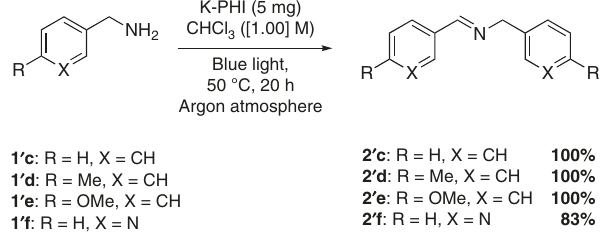
Fig. 5 Oxidative coupling of benzylamines. GC-MS yields are shown.